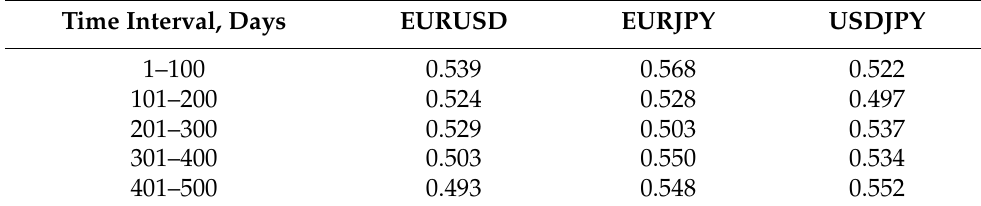
Table 2. Positive outcome frequency at dL = 50.